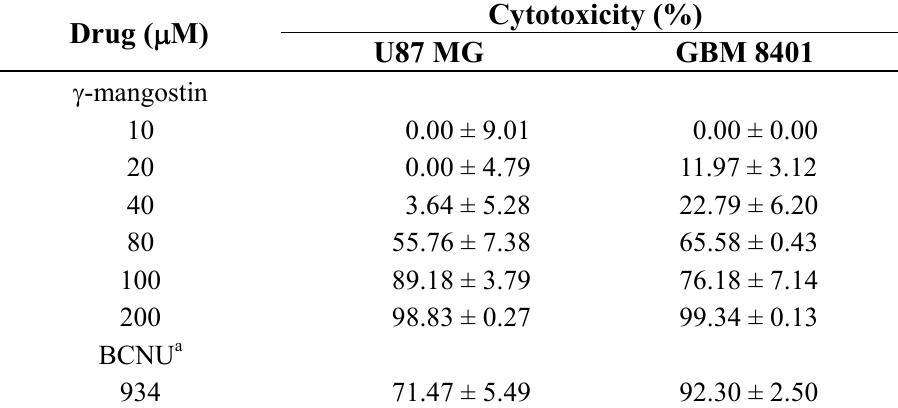
Table 1. Cytotoxicity of γ -mangostin in human glioblastoma cells. Cells treated with different doses of γ -mangostin for 24 hours. Cytotoxicity determined by MTT assay (method described in